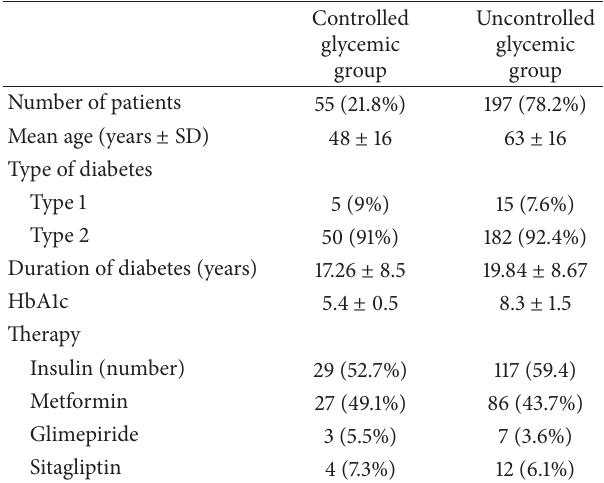
Table 1: Characteristics of the study subjects with controlled and uncontrolled